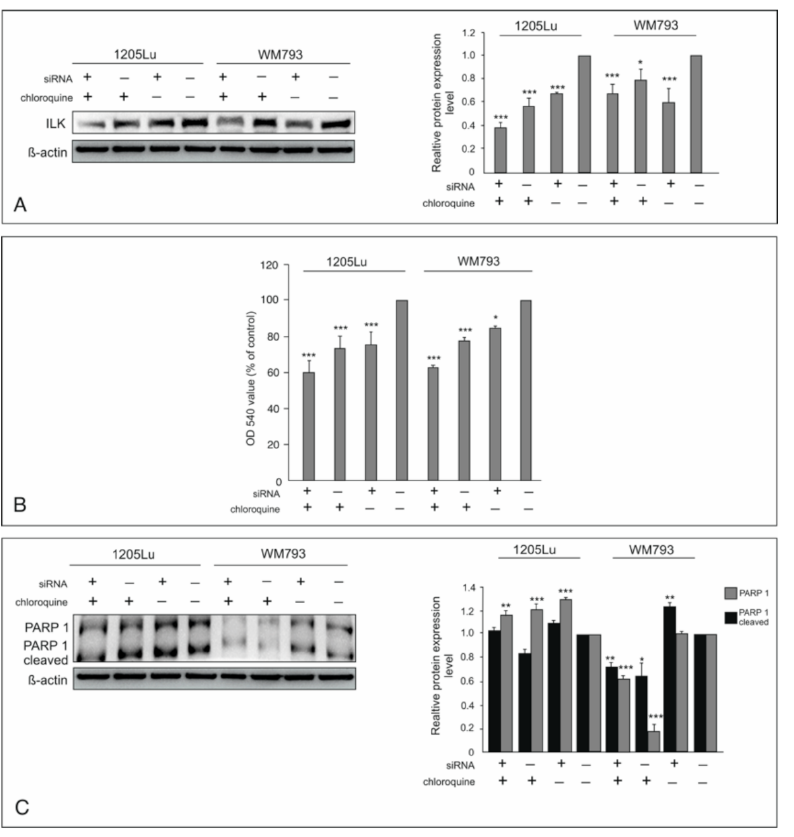
Figure 1. The inhibitory effect of ILK knockdown and CQ use on the survival of melanoma cells. “+” refers to siRNA ILK or chloroquine; “ − ” refers to silencer negative control cells. All results are presented as % of control; asterisk (*) indicates a significant difference: * p < 0.05, ** p < 0.01, *** p < 0.001. ( A )—the expression of ILK after silencing detected by Western blotting in the presence or absence of CQ. ( C )—Effect of ILK knock-down and CQ use on cleaved PARP-1. Representative blots are displayed and quantitative representation of data after densitometry (mean ± SD) of three independent experiments on histograms. B-actin was used as a protein loading control. ( B )—Cell proliferation was assessed with the crystal violet test. Values are expressed as mean ± standard deviation in 6 wells in three independent